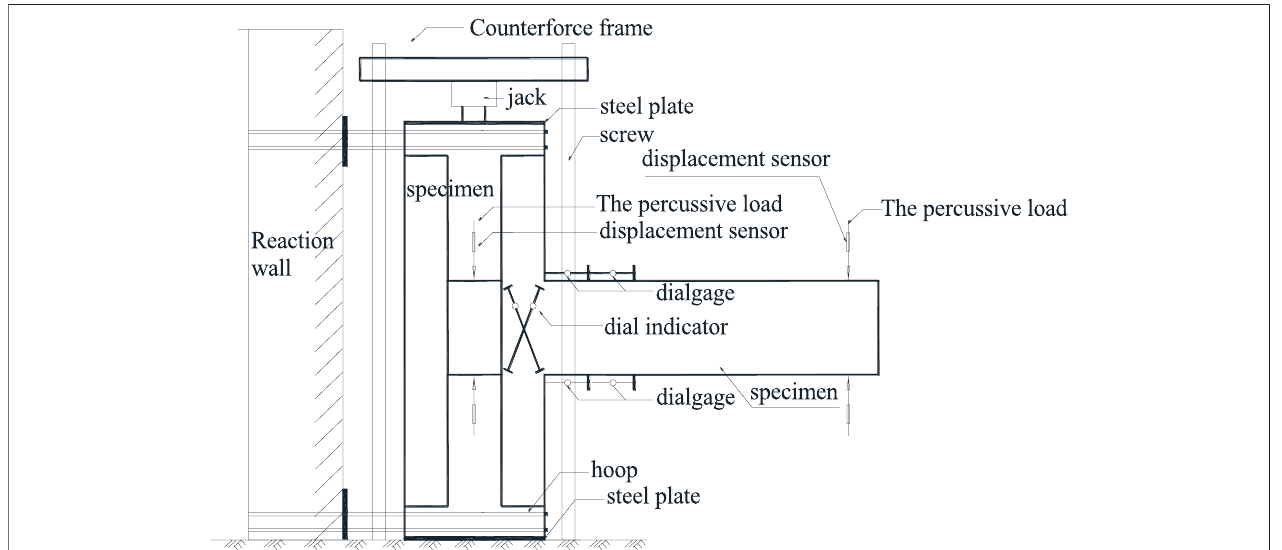
FIGURE 13 | Experimental equipment (Xiang et al., 2017; Xiang et al., 2019).